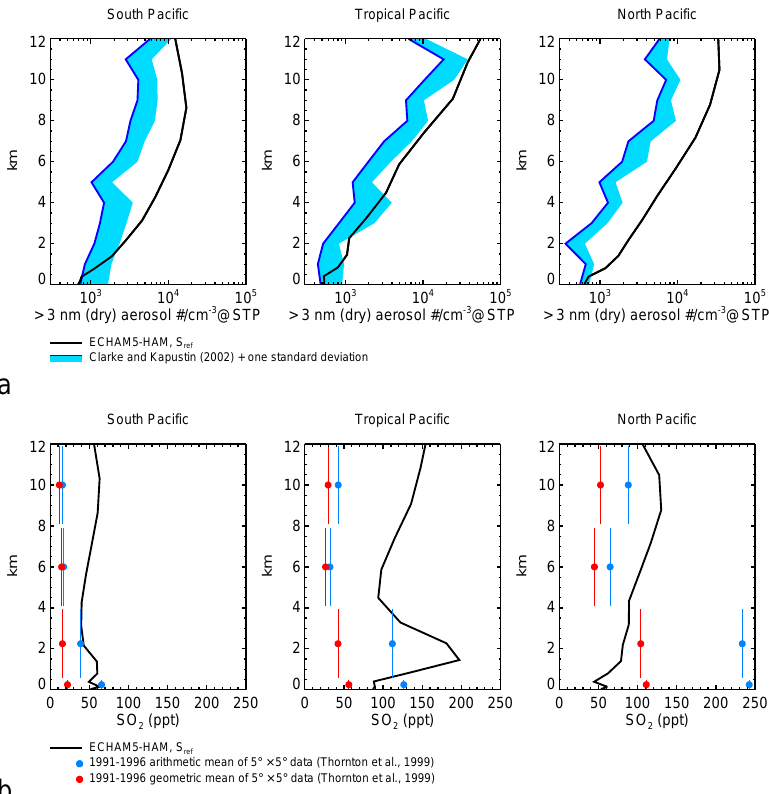
Fig. 1. Comparison of annual mean model results from simulation S ref with observations in three regions of the Pacific Ocean. (a) Model concentration of ultrafine aerosol particles, and observations (Clarke and Kapustin, 2002). (b) Model SO 2 number mixing ratio and obser- vations from Thornton et al. (1999), grouped in the altitude bands 0–0.5km, 0.5–4km, 4–8km, and 8–12km, indicated by vertical bars, in blue (arithmetic mean) and red (geometric mean).